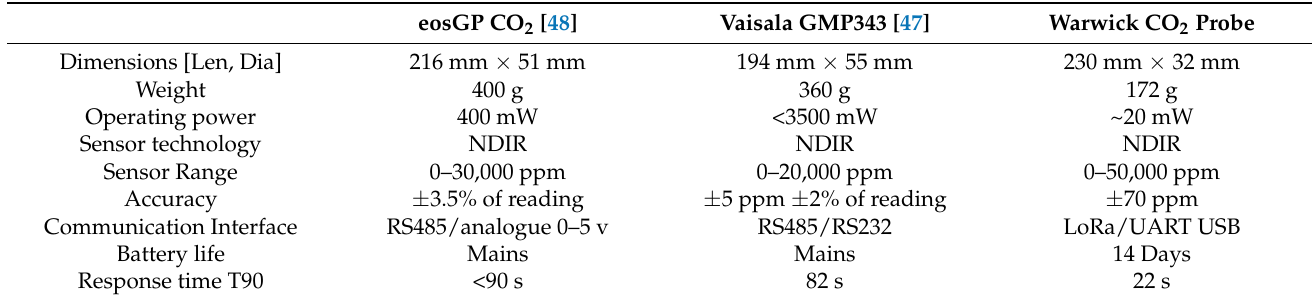
Table 3. Comparison of our reported soil probe system to commercial